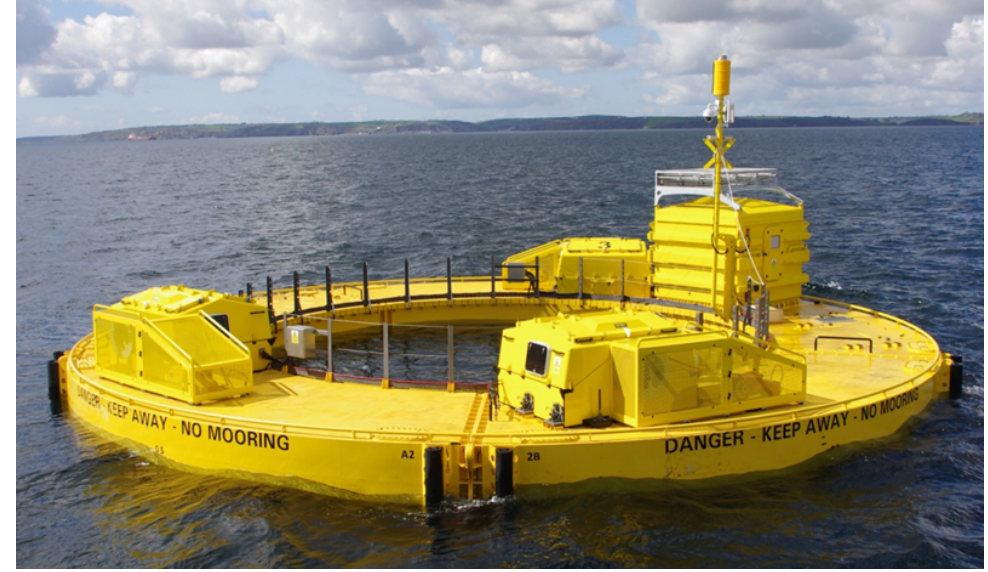
Figure 1. Lifesaver on site outside Falmouth,